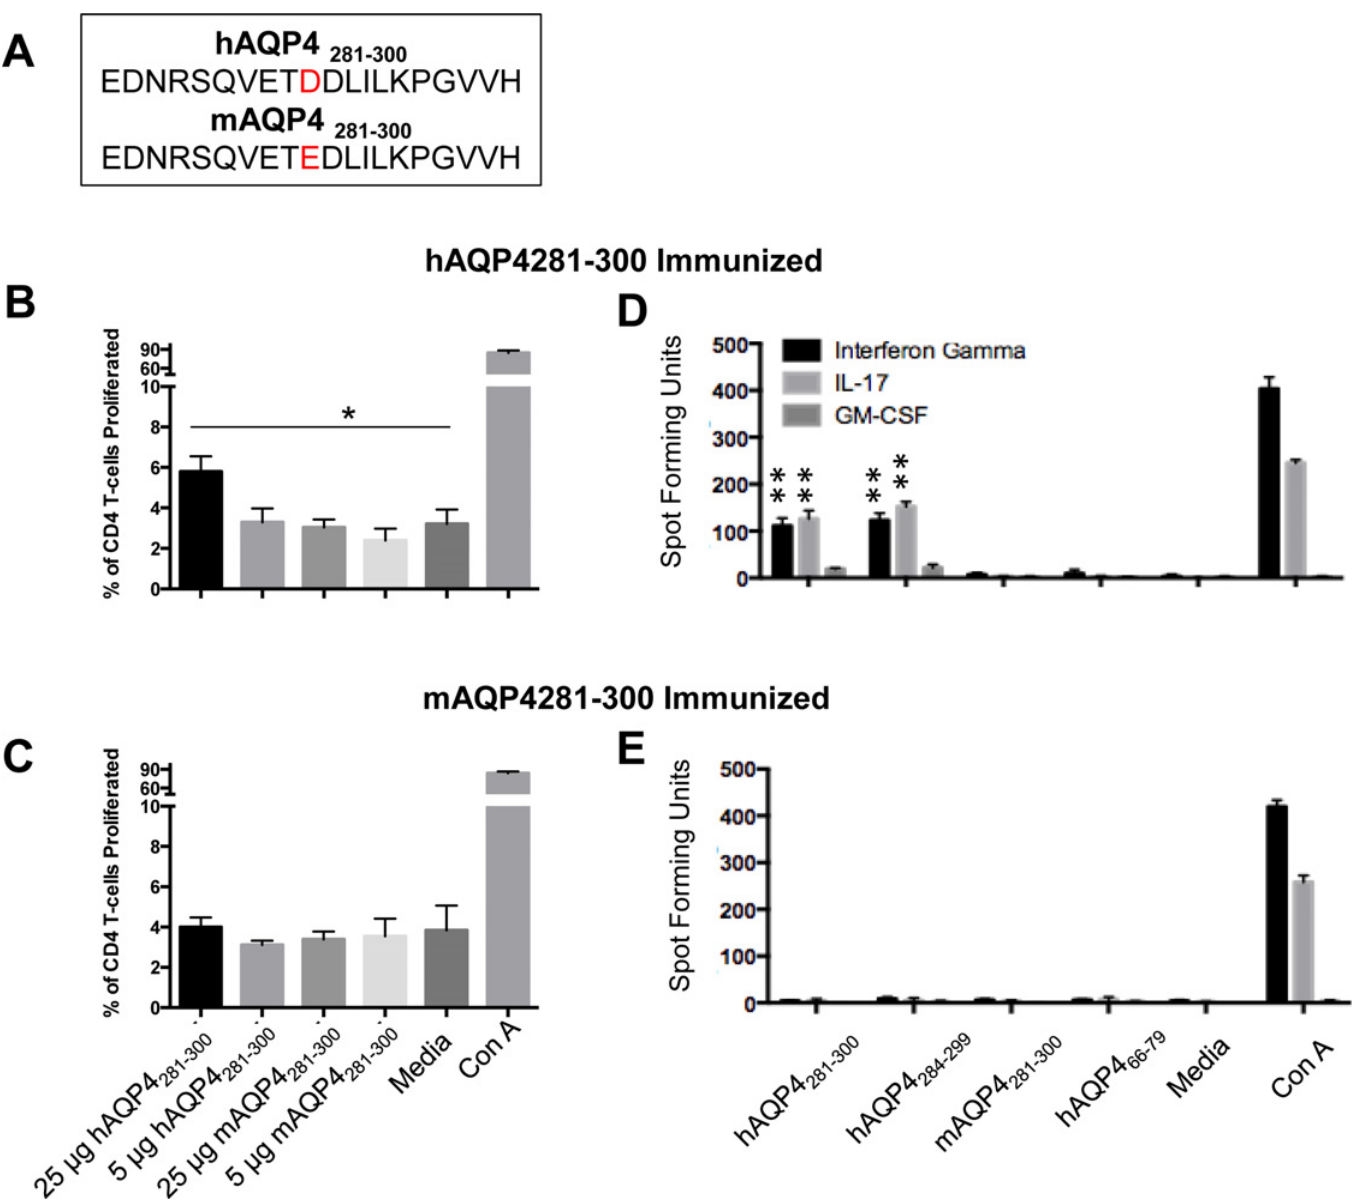
Fig 3. Human (h)AQP4 281-300 -specific T cells do not cross-react with murine (m) AQP4 281-300. (A) There is that a single amino acid substitution from aspartic acid in hAQP4 to glutamic acid in murine (m)AQP4 at position 290. (B) In lymph node cells of HLA-DRB1 * 03 : 01 mice immunized with hAQP4 281-300 there was a significant proliferation of CD4 + T cells when hAQP4 281-300 was used as the recall antigen ( * = P-value = 0.01). Only a higher recall antigen dose of 25 μ g/ml resulted in a significant increase in proliferation, whereas as a dose of 5 μ g/ml did not. (C) There was no proliferative response to mAQP4 281-300 at either dose . (D) There is a significantly increased frequency of IFN γ and IL-17 producing lymph nodes cells from HLA-DRB1 * 03 : 01 mice immunized with hAQP4 281-300 by ELISpot assay when hAQP4 281-300 , and hAQP4 281-299 are used as recall antigens. However, we were unable to detect antigen specific IFN γ and IL-17 producing lymph nodes cells when mAQP4 281-300 , or the negative control hAQP4 66-79 were used as recall antigens ( ** = P-value < 0.01). (E) IFN γ and IL-17 producing lymph nodes cells from HLA-DRB1 * 03 : 01 mice immunized with mAQP4 281-300 were undetectable with any of the recall